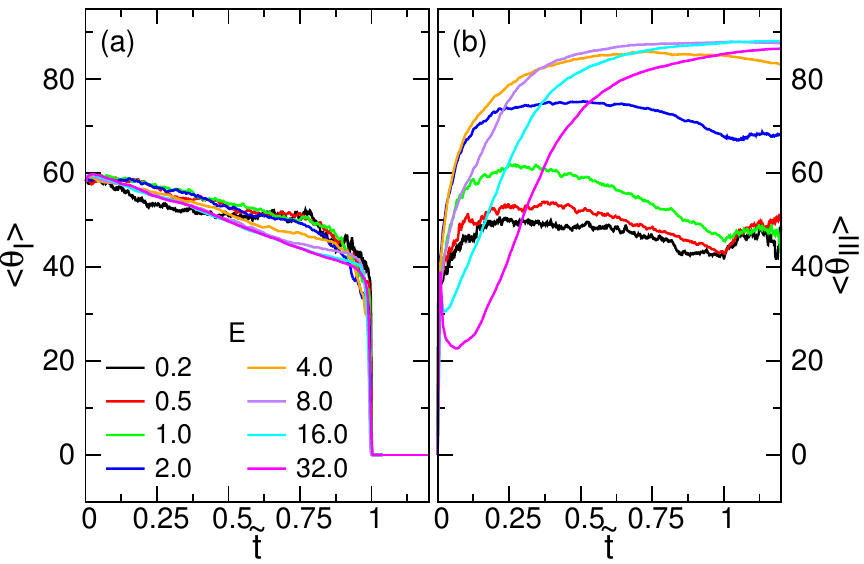
Figure 4. Variations of the averaged polar angle ( a ) (cid:104) θ I (cid:105) and ( b ) (cid:104) θ III (cid:105) in degrees ◦ , as a function of the scaled time ˜ t at different driving electric fields E . The number of monomers of the chain N is